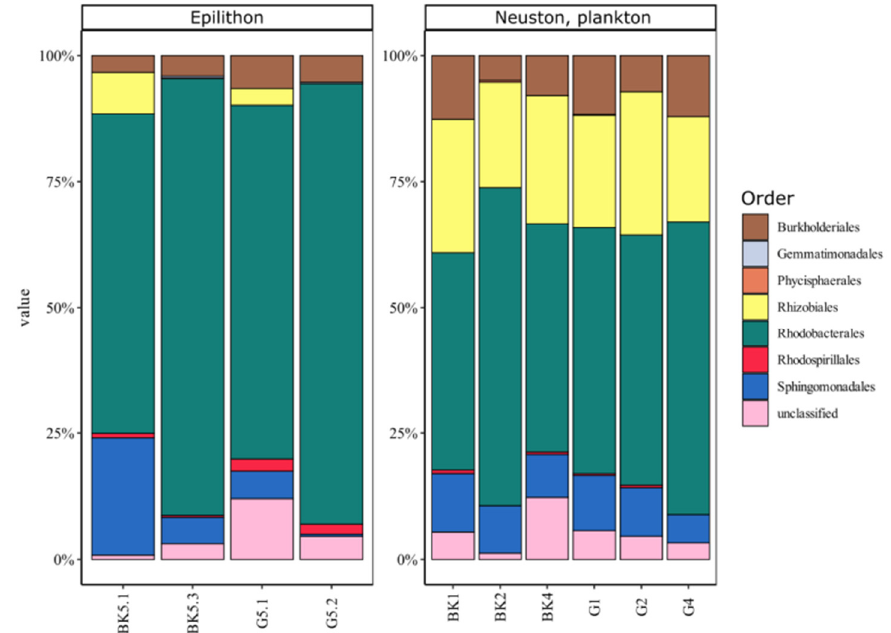
Figure 5. Taxonomic identification of pufM gene reads of epilithon (G5.1, G5.2, BK5.1, BK5.3), neuston (BK1, G1), and plankton (BK2, BK4, G2, G4) of Lake Baikal at the order level. BK—samples taken off the Bol’shiye Koty settlement; G—samples taken off the Bol’shoye Goloustnoye settlement. Table 3. pufM gene sequences detected in Lake Baikal identified to the genus level.